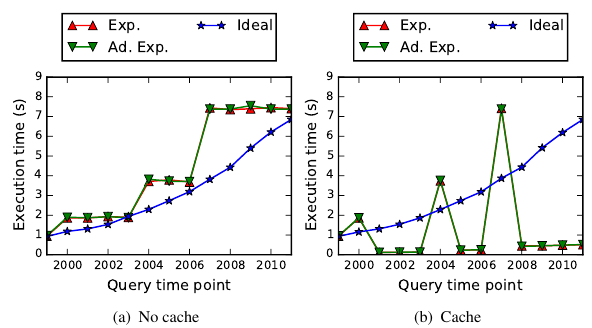
Fig. 9 Global query performance on dblp graph with different time-split policies.